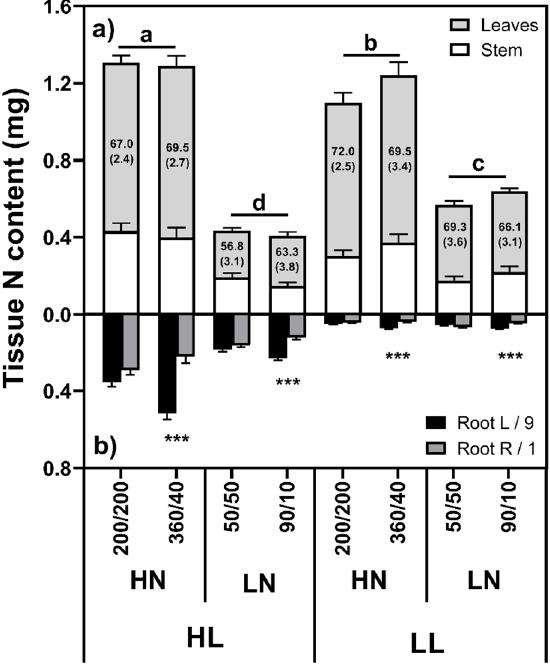
Figure 2. Shoot ( a ) and root ( b ) N contents of Poa annua plants grown under high (HL) or low light (LL) conditions and supplied either high (HN: 400 µg/2 days) or low (LN: 100 µg N/2 days), distributed either equally (200/200 or 50/50) or unequally (360/40 or 90/10) between root box chambers, where n = 12. Numbers in the bars (means ± SE) indicate the percentage of shoot N content attributable to the lamina. Different letters in the shoot graphs indicate statistically significant differences between light and nitrogen treatments. Asterisks in the root graphs denote significant differences ( p < 0.001 ***).